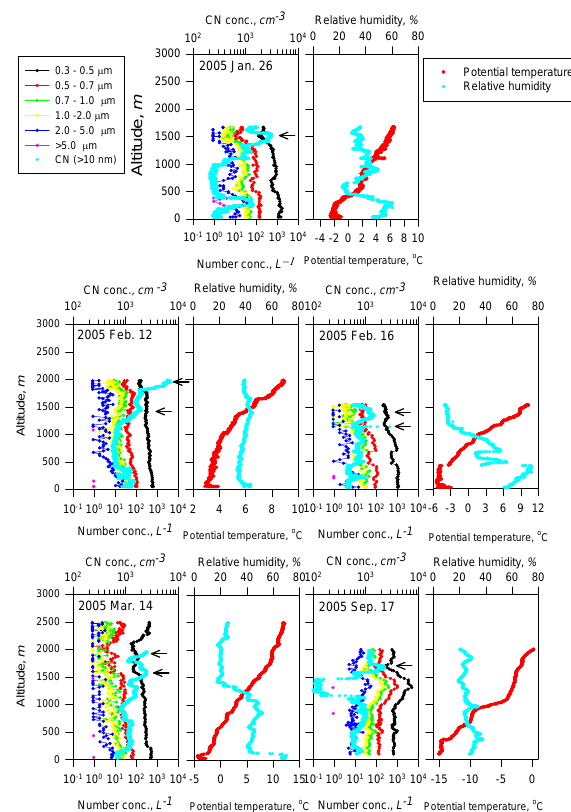
Fig. 5. Vertical distributions of the number concentration of aerosols, relative humidity and potential temperature in the case of appearance of CN-enhanced layer over Syowa